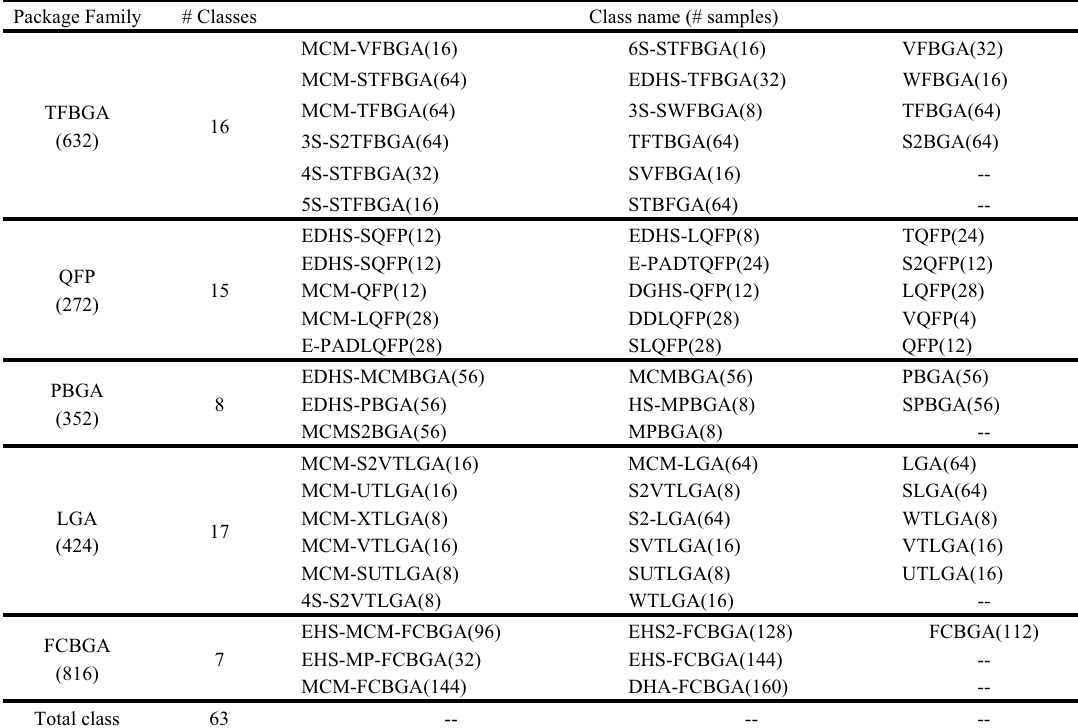
Table 1. Description of the multi-class in the IC Package Type